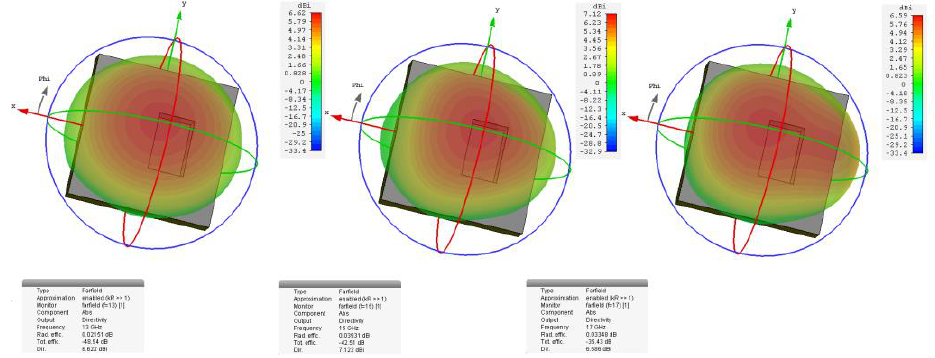
Fig. 5. Emitter model: bottom view (a) and top view (b).